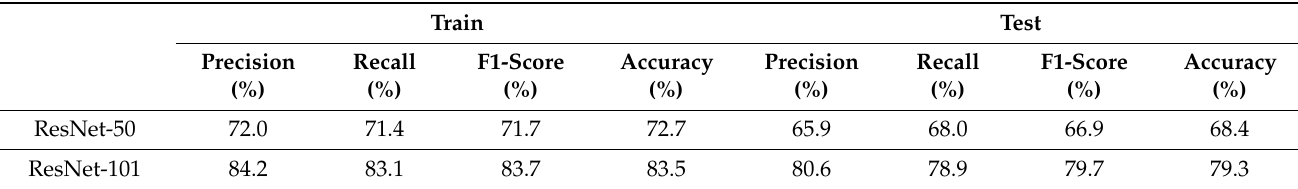
Table A1. Performance results of ResNet-50 and